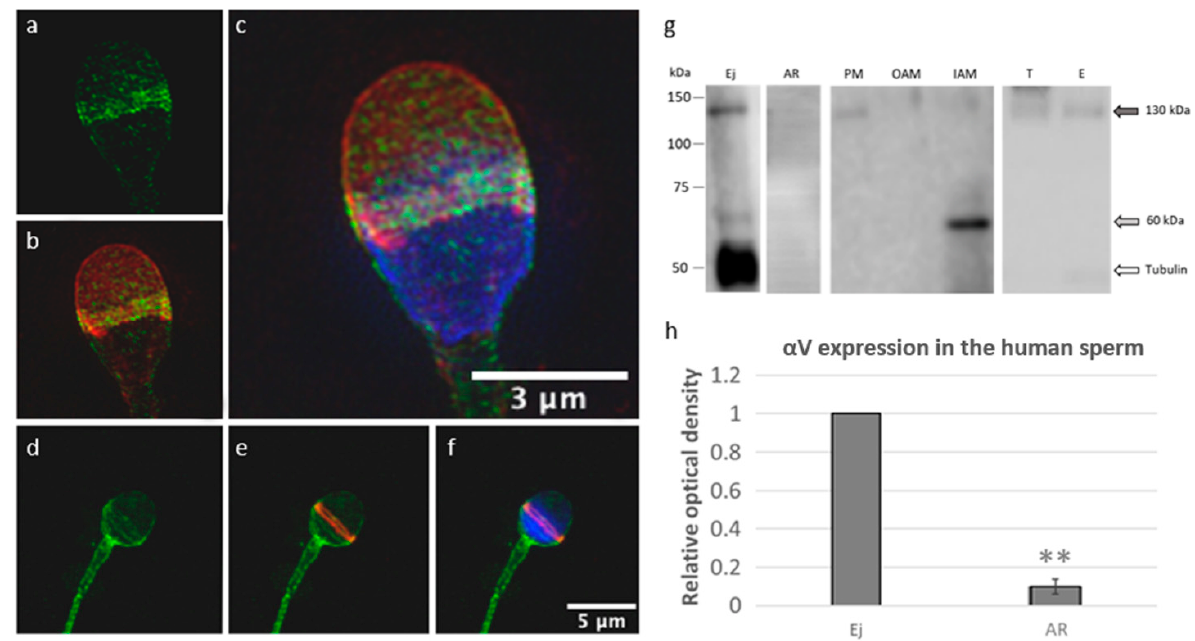
Figure 5. Detection of α V integrin in human spermatozoa and reproductive tissue. ( a–c ) The α V integrin (green) localization on acrosome-intact ejaculated sperm was visualized by SIM and confined to the PM, OAM, and IAM overlaying the apical acrosome and equatorial segment. ( d–f ) The α V integrin (green) localization after the acrosome reaction was captured by confocal microscopy and depicted in IAM and the PM overlaying the equatorial segment, post-acrosomal region, neck, and tail. Acrosomal status was visualized with PNA staining (red); Hoechst (blue) was used for detection of nucleus. Scale bars represent 3 µM ( a–c ) and 5 µM (d–f). ( g ) Western blot immunodetection of α V integrin in extracts from ejaculated sperm (Ej), acrosome-reacted sperm (AR), PM, OAM, and IAM fractions from ejaculated sperm, testis (T), and epididymis (E). Antibody detected bands with a molecular weight of 130 kDa (gray arrow). ( h ) Western blot densitometry analysis in protein extracts shows a decreased expression of α V integrin ( p < 0.02; **) in acrosome-reacted (AR) sperm in comparison with the ejaculated (Ej) sperm.